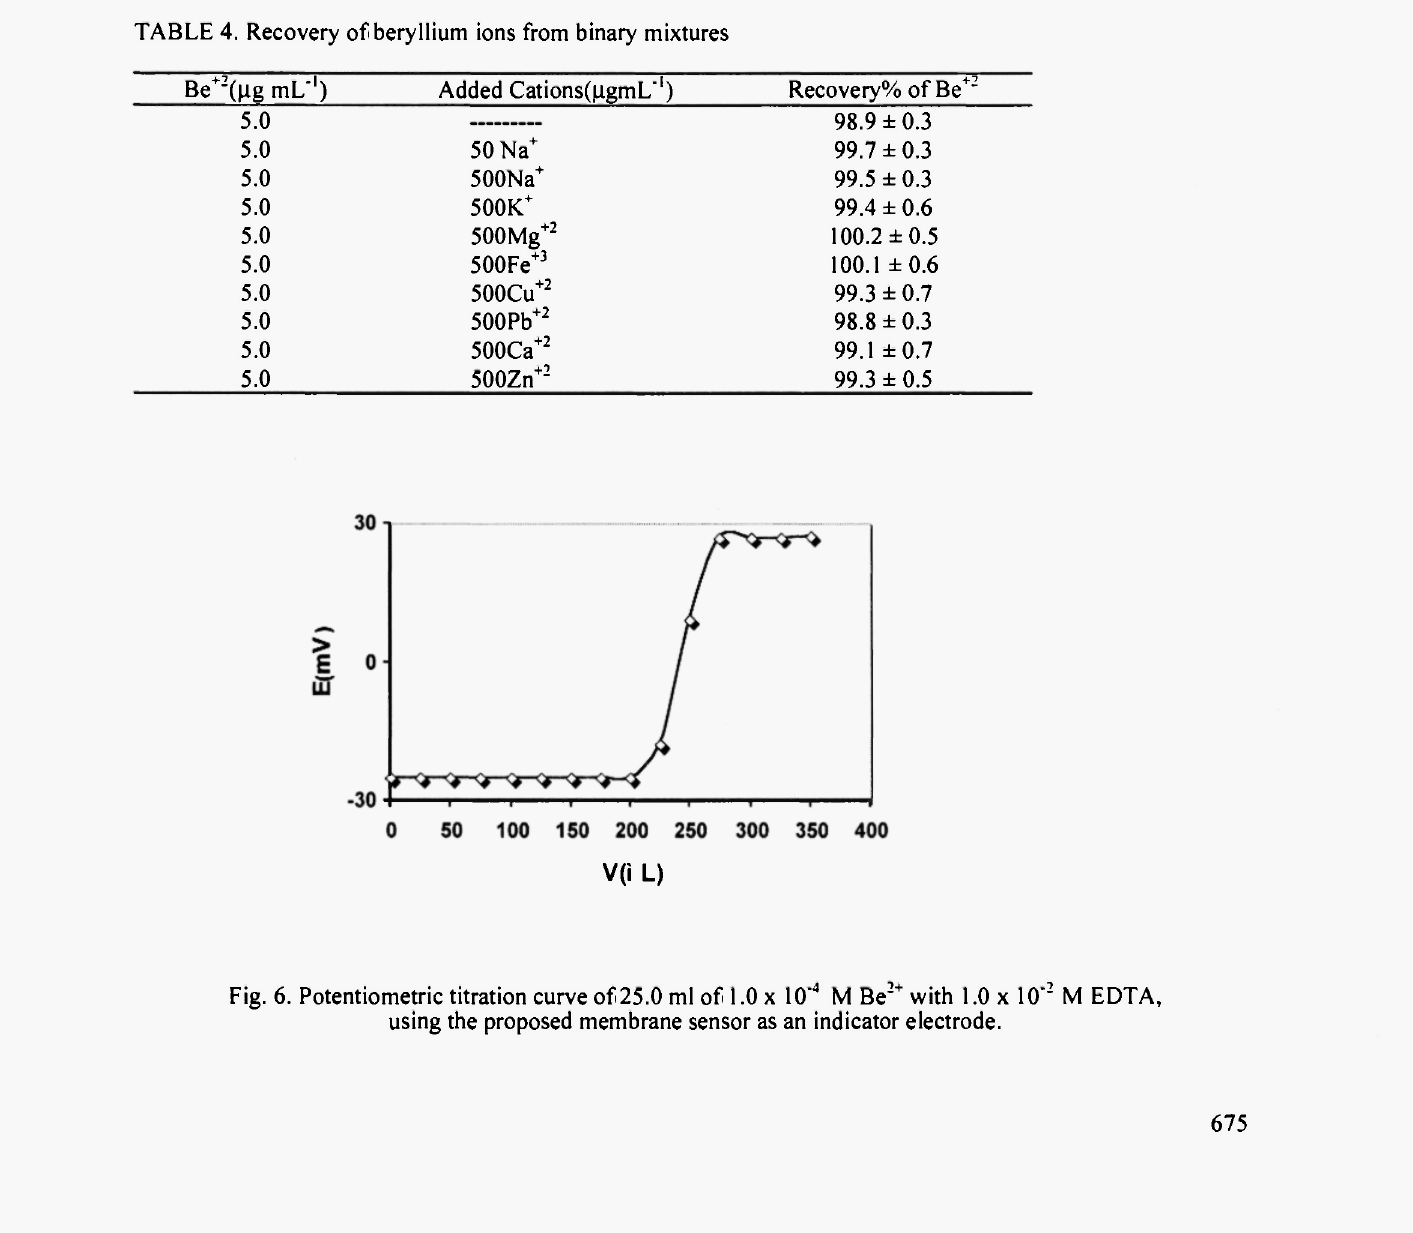
Fig. 6. Potentiometrie titration curve of25.0 ml of 1.0 χ ΙΟ" 4 Μ Be 2+ with 1.0 χ ΙΟ" 2 Μ EDTA, using the proposed membrane sensor as an indicator